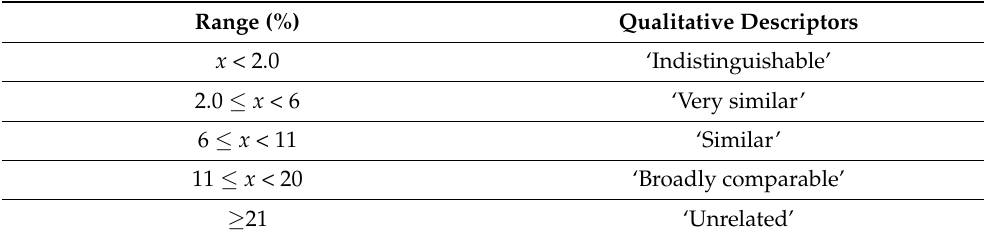
Table 2. Indicative qualitative descriptors used for ranges. Range